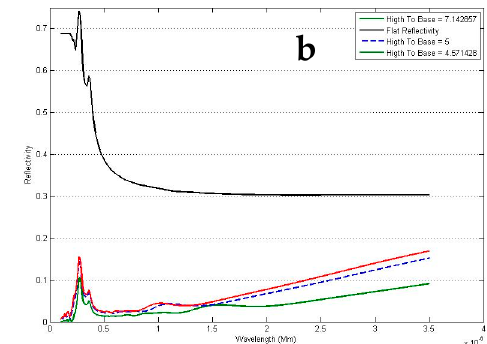
Figure 3. ( a ) Selective periodic texturing with three aspect ratios (64/14, 70/14 and 100/14) for simulation, ( b ) surface spectral reflectance for three triangular microstructures of interest with a base of 14 nm and the aspect ratio of 64/14, 70/14 and 100/14. Note that the green curve addresses a reflectance of less than 10%.